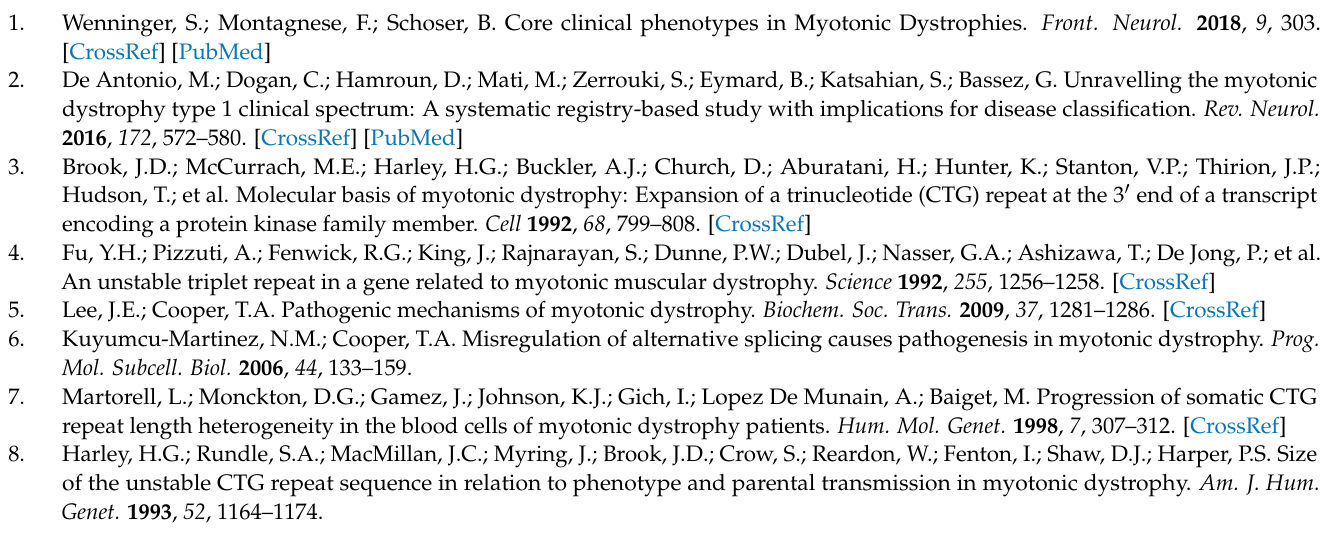
plementary Figure S1: Repeat lengths for all four controls; Supplementary Figure S2: Distribution of most common triplets in the healthy alleles of each patient; Supplementary Figure S3: Nanopore methylation profiles for the controls; Supplementary Figure S4: Correlation analysis; Supplementary Figure S5: Nanopolish data of individual